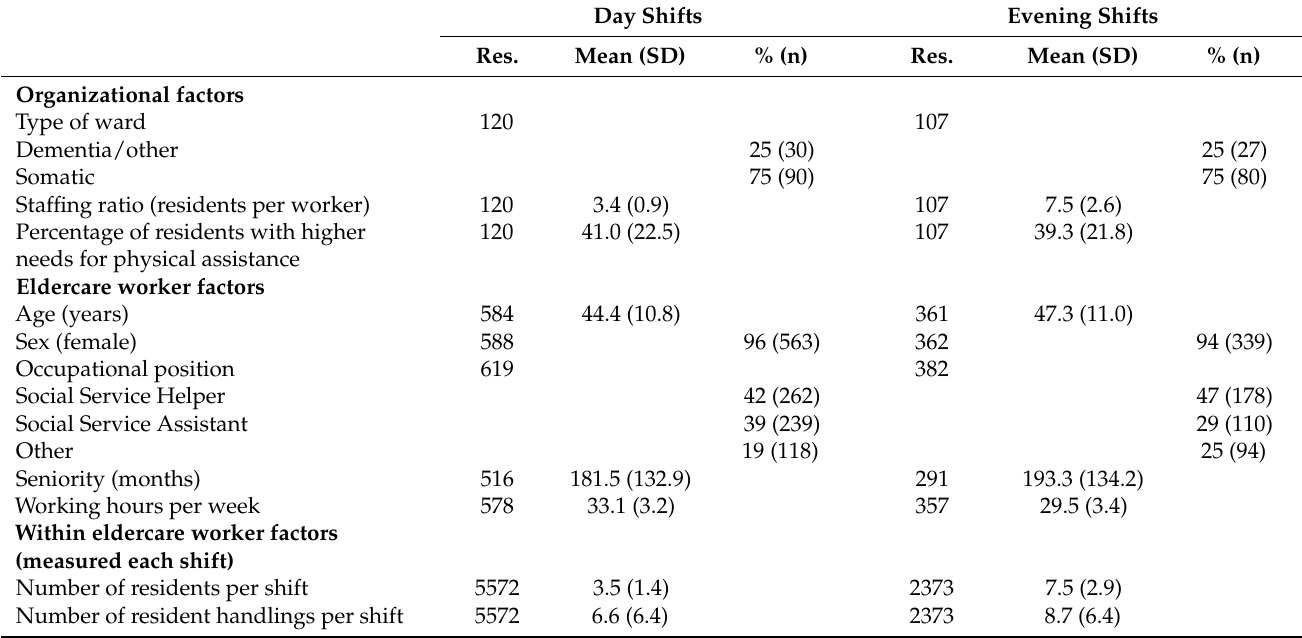
Table 2. Characteristics of organizations on ward level and eldercare workers stratified on day and evening shifts work. (Res. = Respondents/cases; SD = Standard Deviation; % = percent; n =